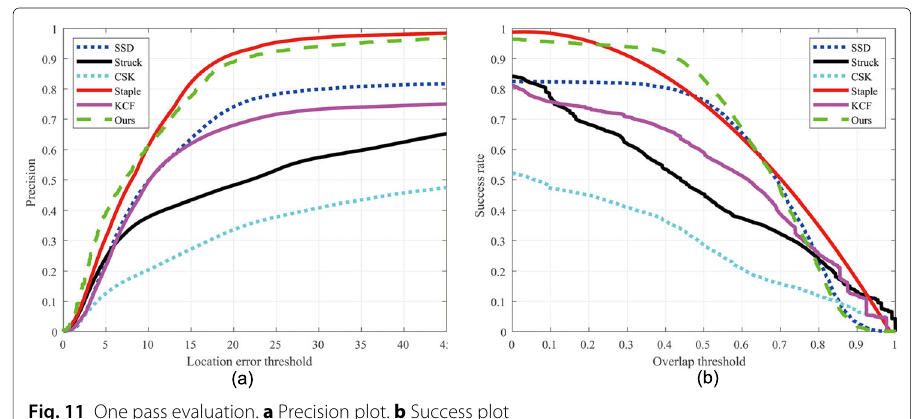
Fig. 11 One pass evaluation. a Precision plot. b Success plot